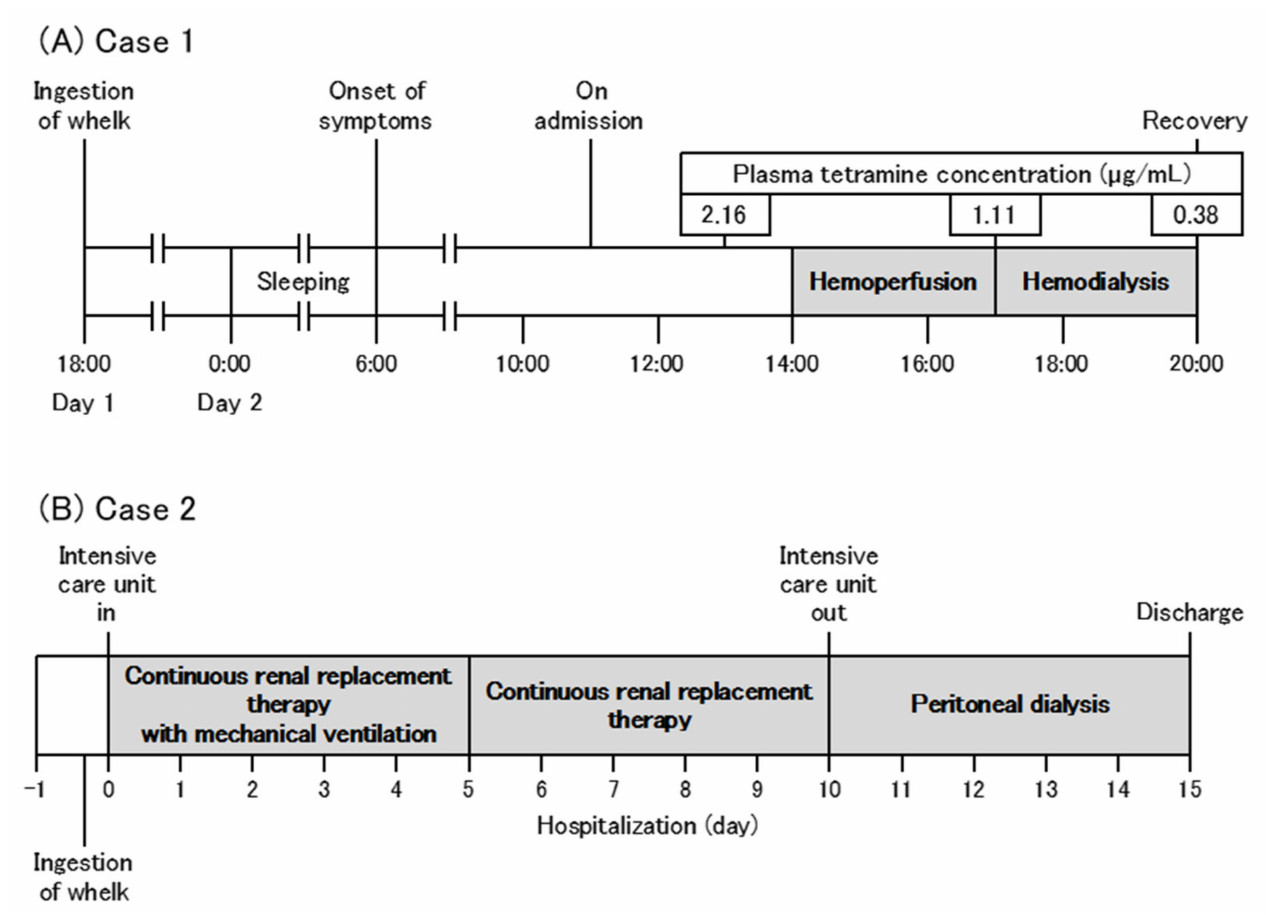
Figure 3. Clinical course of patients with end-stage kidney disease in tetramine poisoning. The shaded areas indicate how long each patient received some treatment. ( A ) Drawn by modi- fication of Figure 2 in the paper of Takasaki et al. [28]. ( B ) Drawn by modification of Figure 3 in the paper of Yeo and Lim